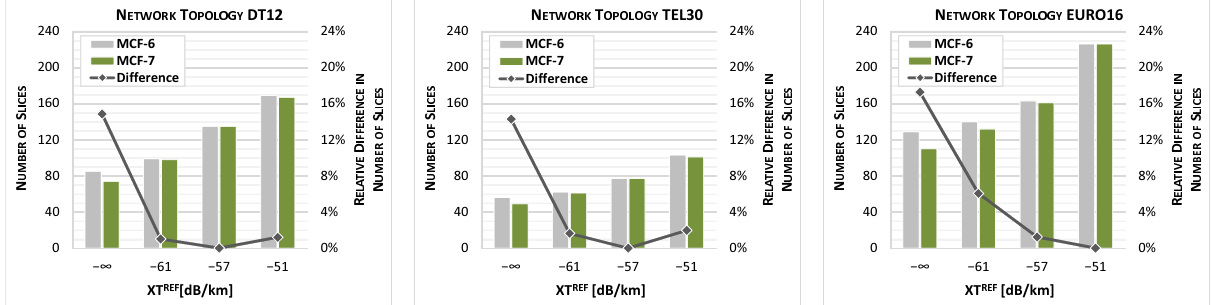
Figure 6. Comparison of network performance for fibers MCF-6 and MCF-7 in different network and crosstalk scenarios assuming |D| = 500: the required number of slices (bars) and relative difference in the number of required slices between both MCF options (lines).